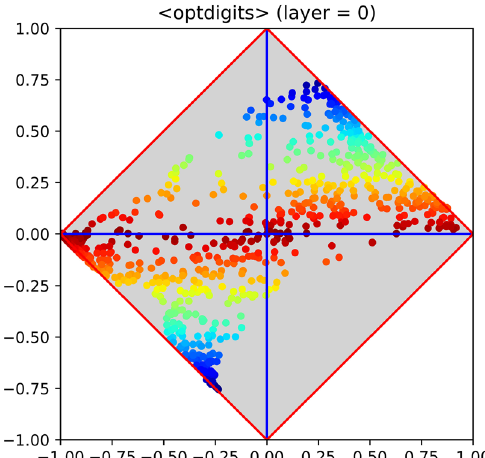
Figure 1. Class signature of the dataset optdigits , downloaded from the UC Irvine machine learning repository (UCI, hereinafter). Each sample is encoded with an image of 32 × 32 B/W pixels, for a total of 1024 binary features. The multiclass problem has been binarized considering the digit 0 as positive category and 1, 2, . . . , 9 as negative category. Each point in the diagram represents the “performance” of a feature, considered as an elementary classifier. Feature importance is highlighted by a scale of colours: from red (not relevant) to blue (highly relevant). Intermediate values are represented with yellow, green and light blue, depending on the corresponding feature importance (from lower to higher). Due to the presence of several points with high value of |δ|, the problem is expected to be